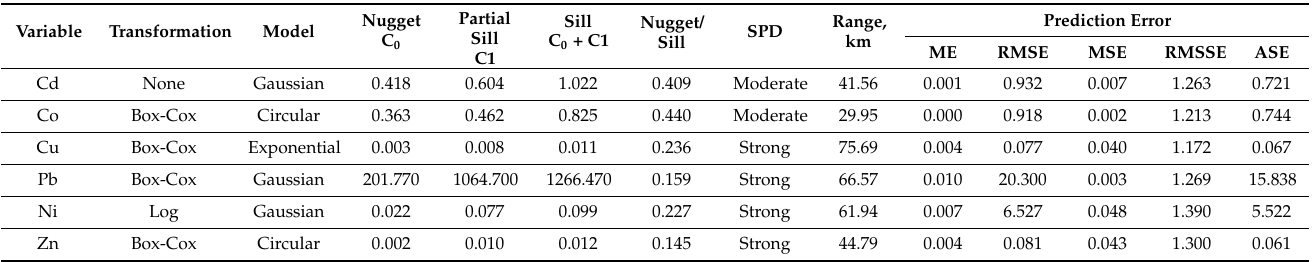
Table 4. Semivariogram parameters of the best-fitted ordinary kriging models used for predicting metal